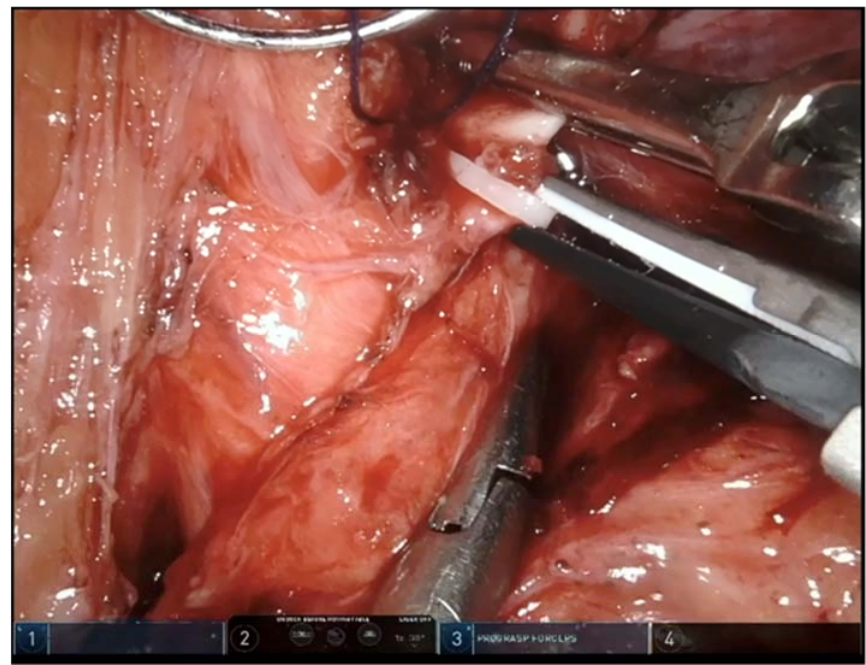
Figure 3 . Tip of the harmonic scalpel placed carefully for a precise division of the clip to avoid SMA injury .